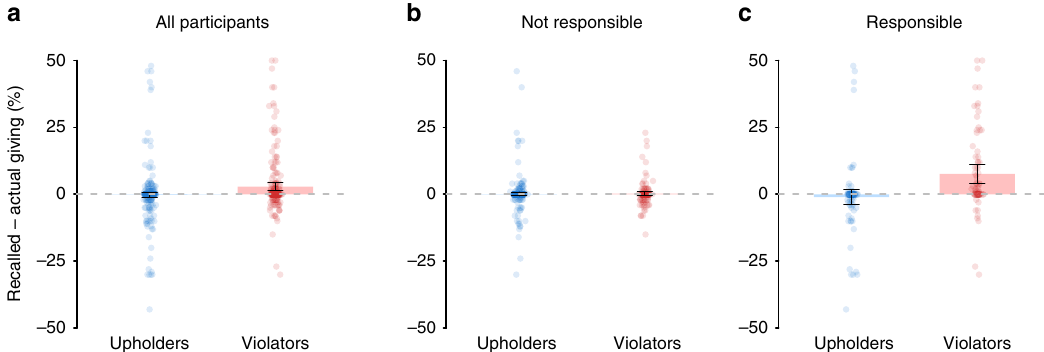
Fig. 3 Motive-dependence of self-serving memory errors. a In Experiment 4b, forced-choice violators exhibited more self-serving memory errors than forced-choice upholders. But crucially, this effect depends on whether violators felt responsible for their fairness violations. b Forced-choice violators who perceived no responsibility for their actions showed no self-serving memory errors. c In contrast, forced-choice violators who nonetheless still perceived themselves as responsible for their actions exhibited self-serving memory errors. Error bars represent 95%